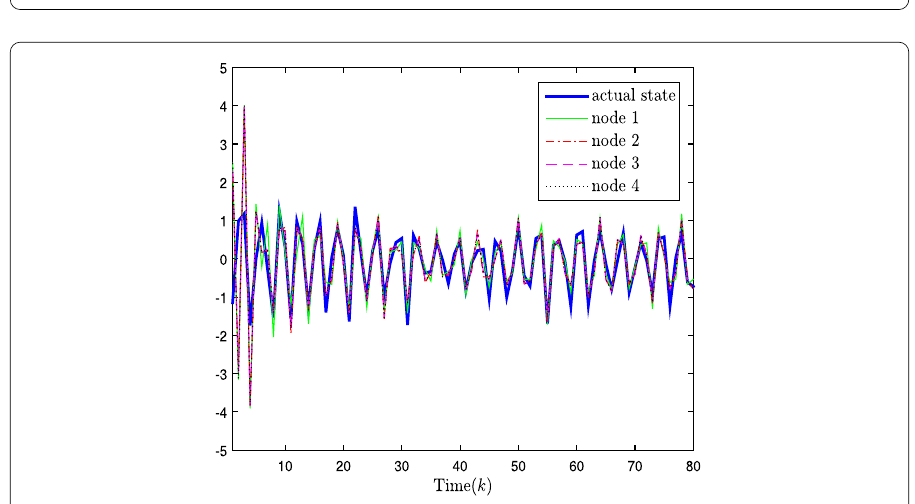
Figure 8 The actual state x 1, k and the corresponding estimates